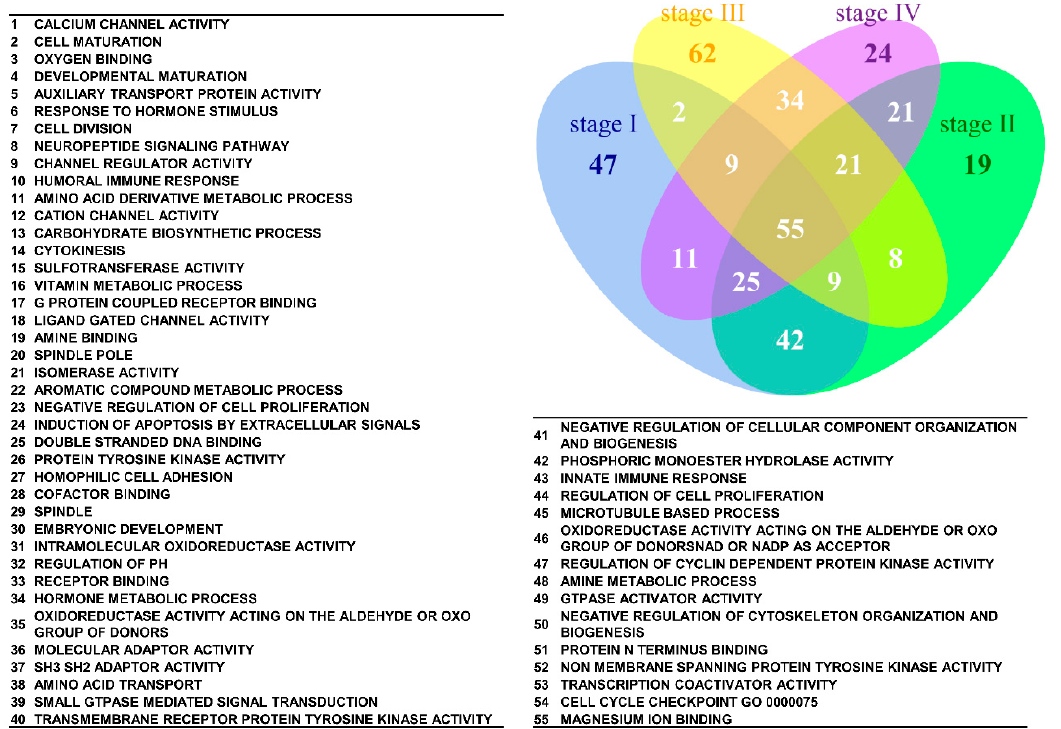
Figure 4. Venn diagram of the 200 most significantly deregulated GO terms for the stage I–IV